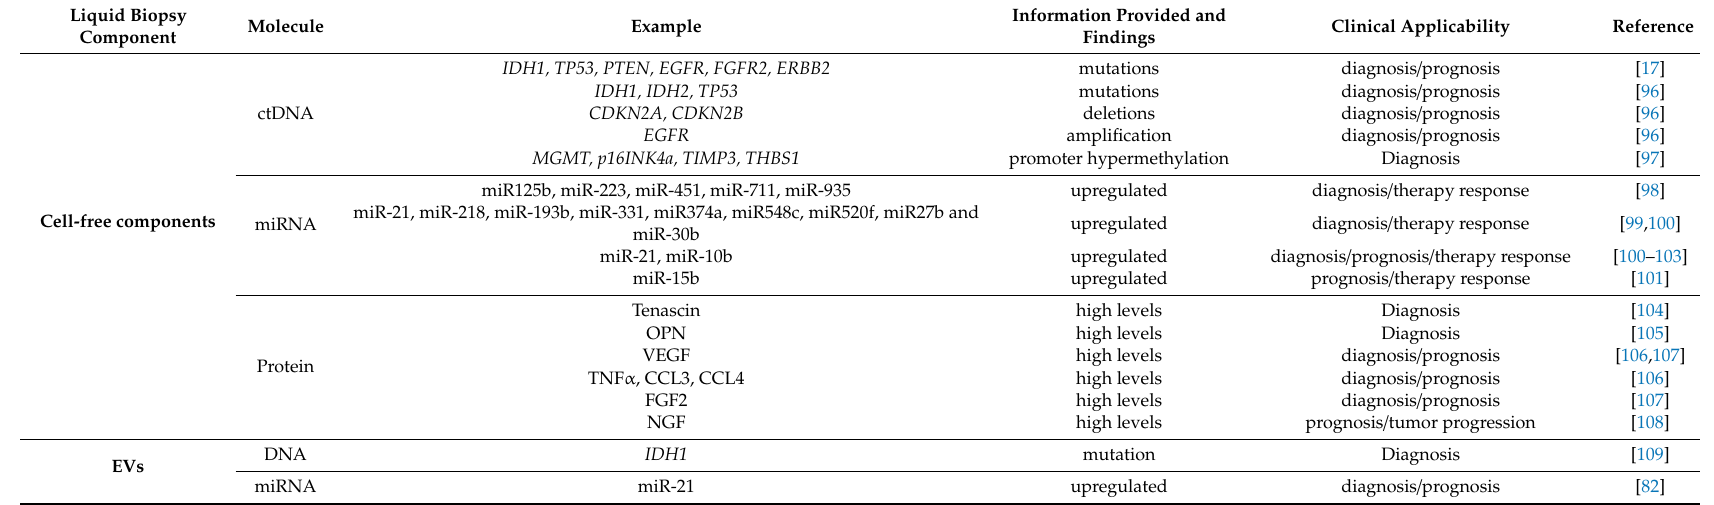
Table 2. Components identified in the cerebrospinal fluid (CSF) of glioblastoma